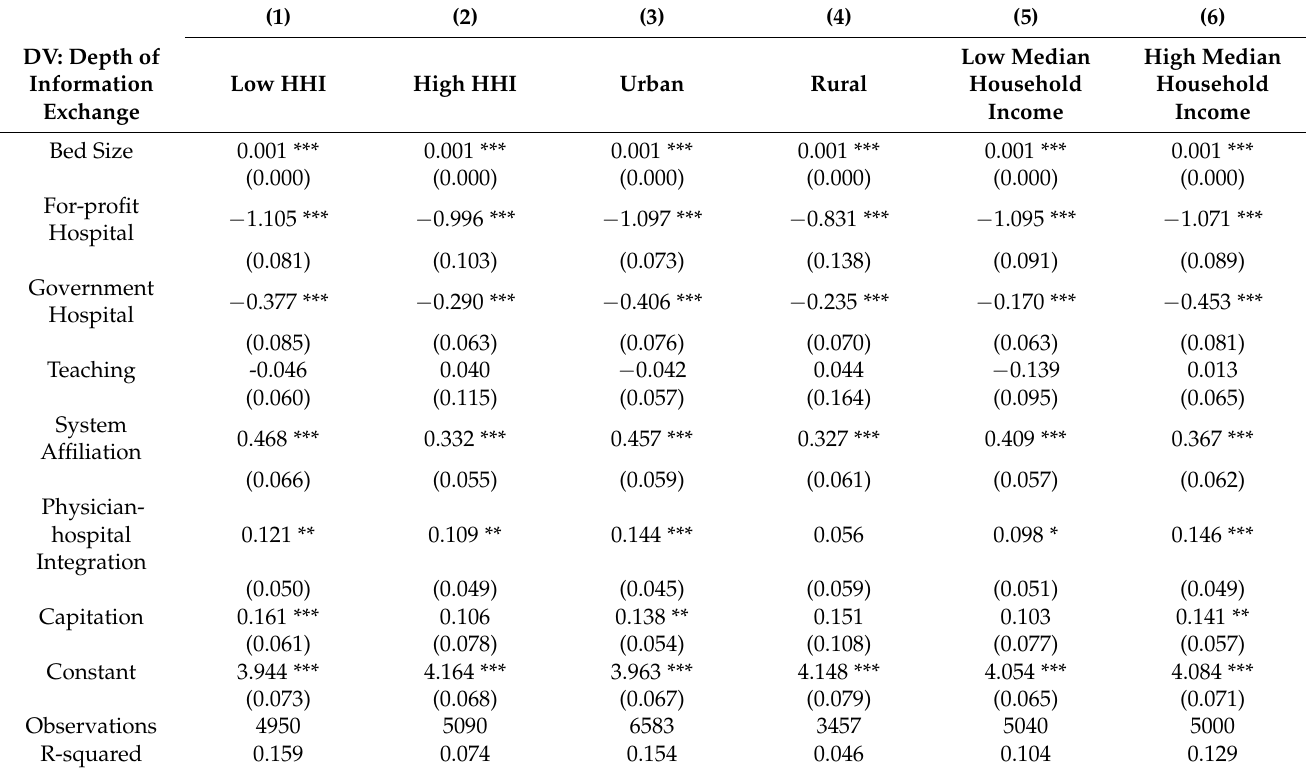
Table 4. Sub-sample Analysis—Depth of Information